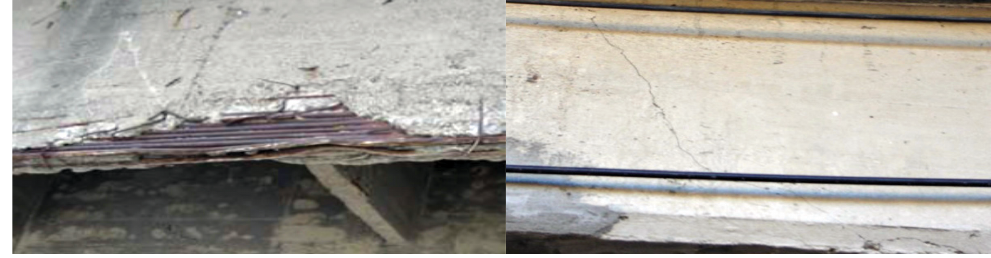
(a) Dense reinforcement (b) Shear crack at beams